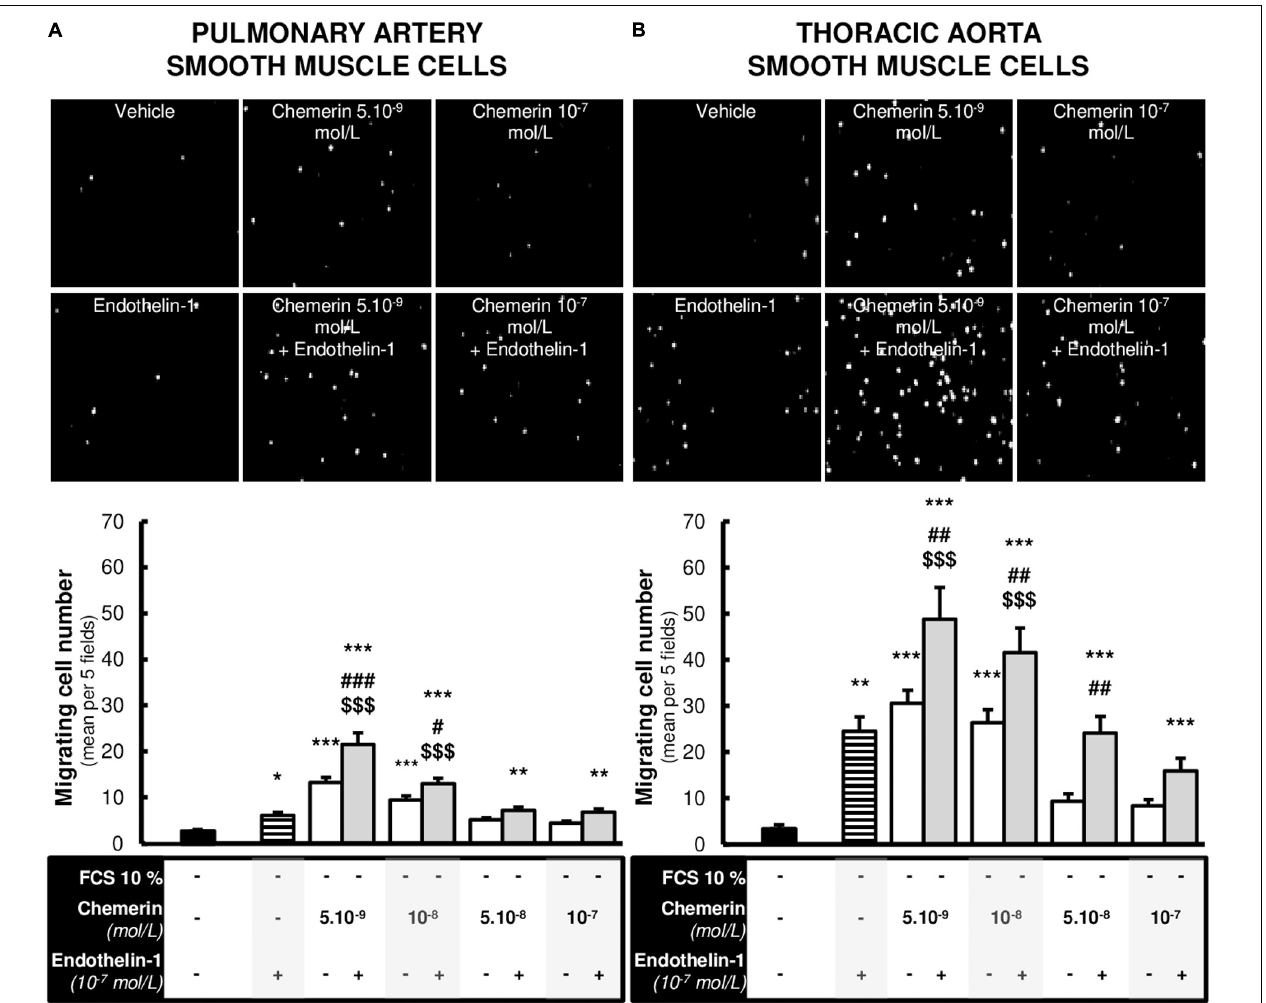
FIGURE 5 | Chemerin-induced migration of pulmonary artery and thoracic aorta smooth muscle cells. Representative contrasted images and quantification of in vitro migration of primary cultured pulmonary artery [ (A) , 12 experiments in total] and thoracic aorta [ (B) , 9 experiments in total] smooth muscle cells isolated from Wistar rats ( n = 4), in the modified Boyden exposed or not to recombinant rat endothelin-1 (10 − 7 mol/L) with or without increasing concentrations of recombinant mouse chemerin (tested from 5.10 − 9 to 10 − 7 mol/L) for 24 h. Migration responses were expressed as mean number of migrating cells evaluated in five different fields randomly chosen per insert (at 10 × magnitude) and presented as mean ± SEM. *0.01 < p < 0.05, **0.001 < p < 0.01, *** p < 0.001 compared to basal condition [corresponding to 0% fetal calf serum (FCS)-treated] in the same type of smooth muscle cells; # 0.01 < p < 0.05, ## 0.001 < p < 0.01 and ### p < 0.001 compared to corresponding chemerin-treated cells; $$$ p < 0.001 compared to corresponding endothelin-1-treated cells.